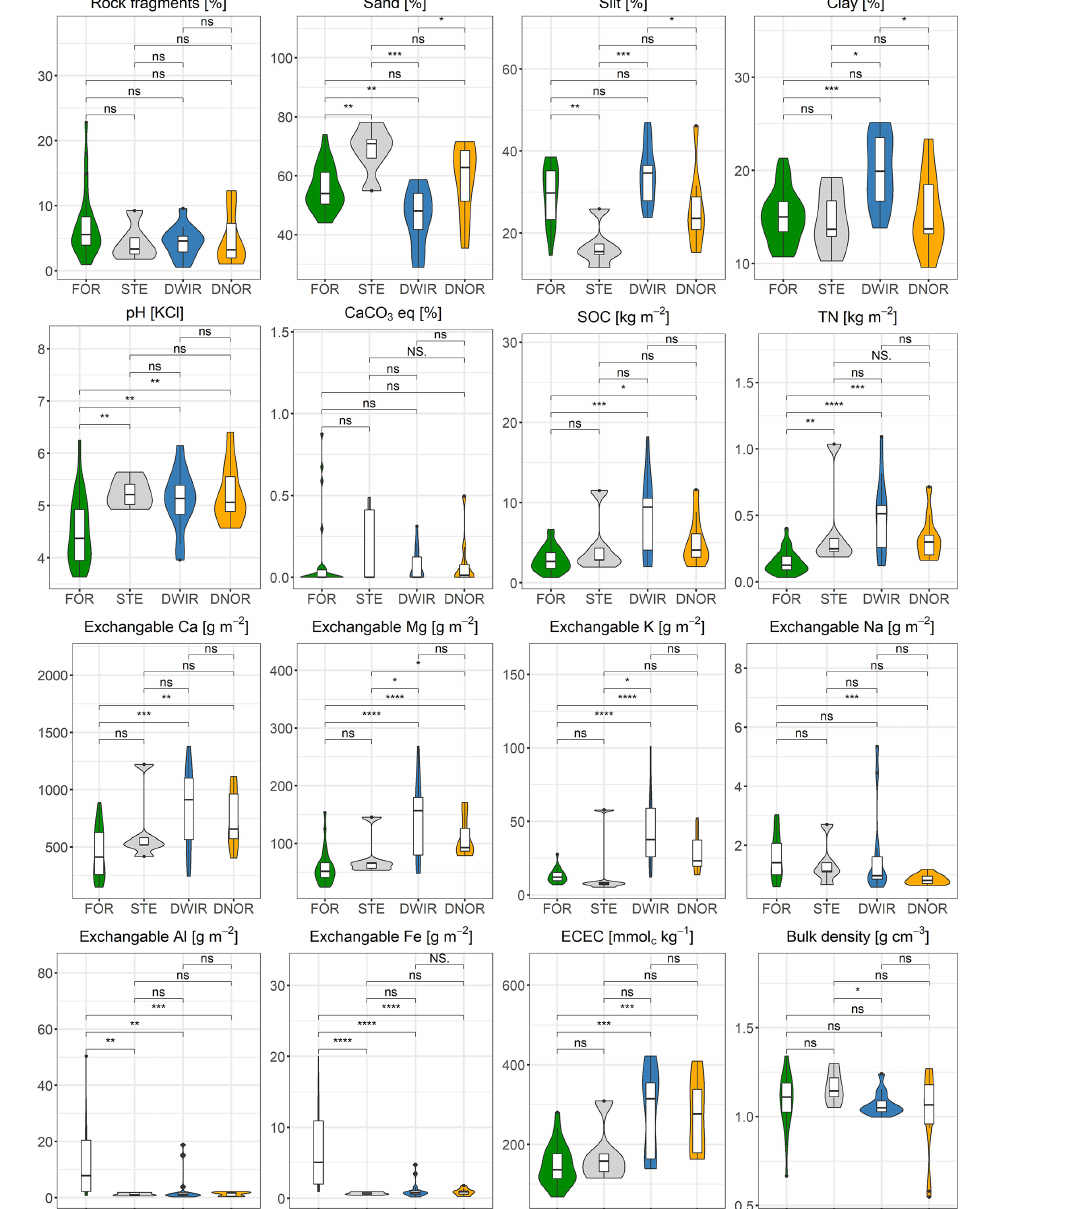
Figure 4. Properties of the uppermost 10cm of the soil profiles under the following four vegetation categories ( n = 54): near-natural forest (FOR; green), steppe close to the forest (STE; grey), disturbed forest with regrowth of trees (DWIR; blue) and disturbed forest showing no regrowth of trees (DNOR; orange). P values indicated above the plots were calculated for differences between the arithmetic means (NS. – p = 1; ns – p> 0 . 05; ∗ – p ≤ 0 . 05; ∗∗ – p ≤ 0 . 01; ∗∗∗ – p ≤ 0 . 001; ∗∗∗∗ – p ≤ 0 . 0001). Horizontal bars are medians, boxes are first and third quartiles, points are outliers, and violins are data